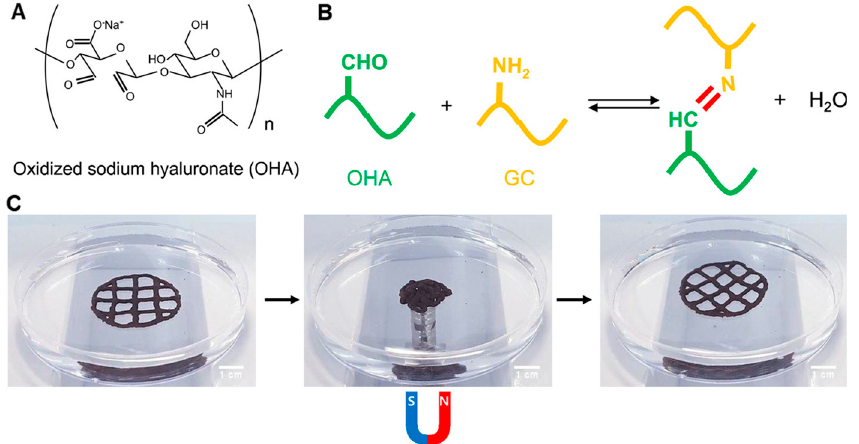
Figure 11. ( A ) Chemical structure of oxidized sodium hyaluronate (OHA). ( B ) Schiff base formation between OHA and glycol chitosan (GC). ( C ) Change in the 3D-printed structure by application of a magnetic field. The original shape was recovered after removal of the magnetic field. Reprinted with permission from [130], Copyright 2020, Elsevier.